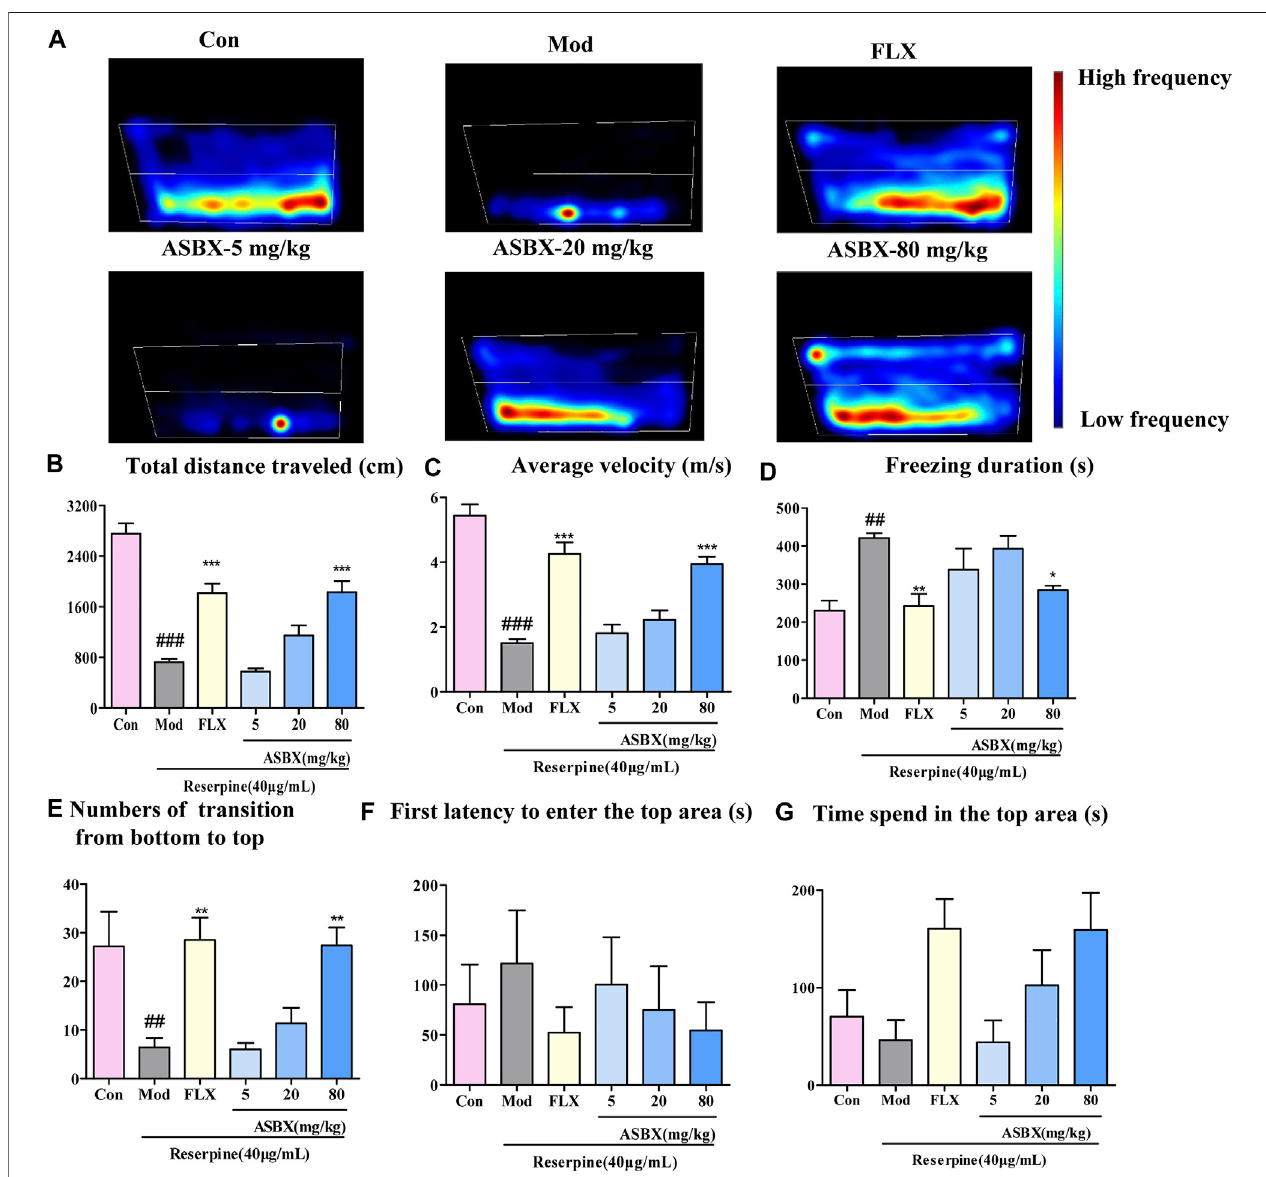
FIGURE1| AntidepressanteffectofAnshenBuxinSixPills(ASBX)wastestedusinganoveltankdivingtest. (A) Heatmapsofthebehaviortrajectory.Thebarchart shows the swimming ability, exploratory behavior, and freezing behavior of adult zebra fi sh. (B) Total distance travelled (cm) (C) Average velocity (cm/s) (D) Freezing duration(s) (E) Numberoftransitionsfrombottomtotop (F) Firstlatencytoentertoparea(s) (G) .Timespendinthetoparea.Dataareexpressedasthemean ± SEM)(n (cid:1) 10/group). Signi fi cance was de fi ned as ## p < 0.01, ### p < 0.001 compared with Con group, * p < 0.05, ** p < 0.01, *** p < 0.001 compared with Mod group.